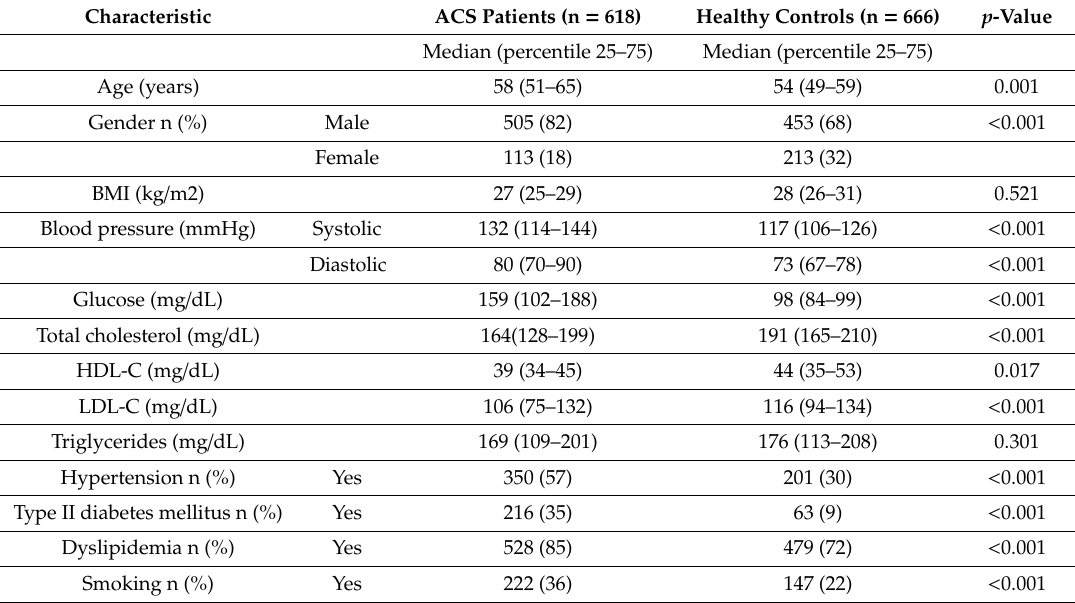
Table 1. Anthropometrics and biochemical parameters of the study